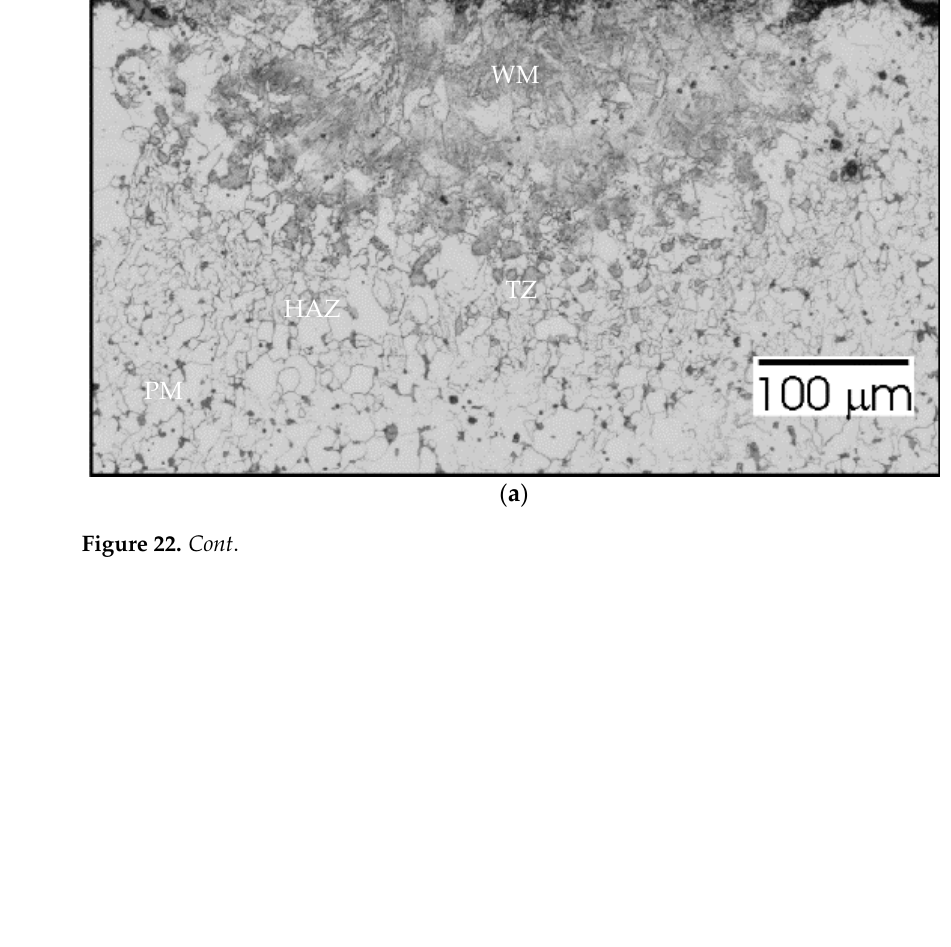
Figure 21. Sample no 1 reached with 50 Hz acoustic vibration delivered transversely: ( a ) Metallography and ( b ) SEM; PM—parent metal, HAZ—heat affected zone, TZ—transition zone, WM—weld metal.